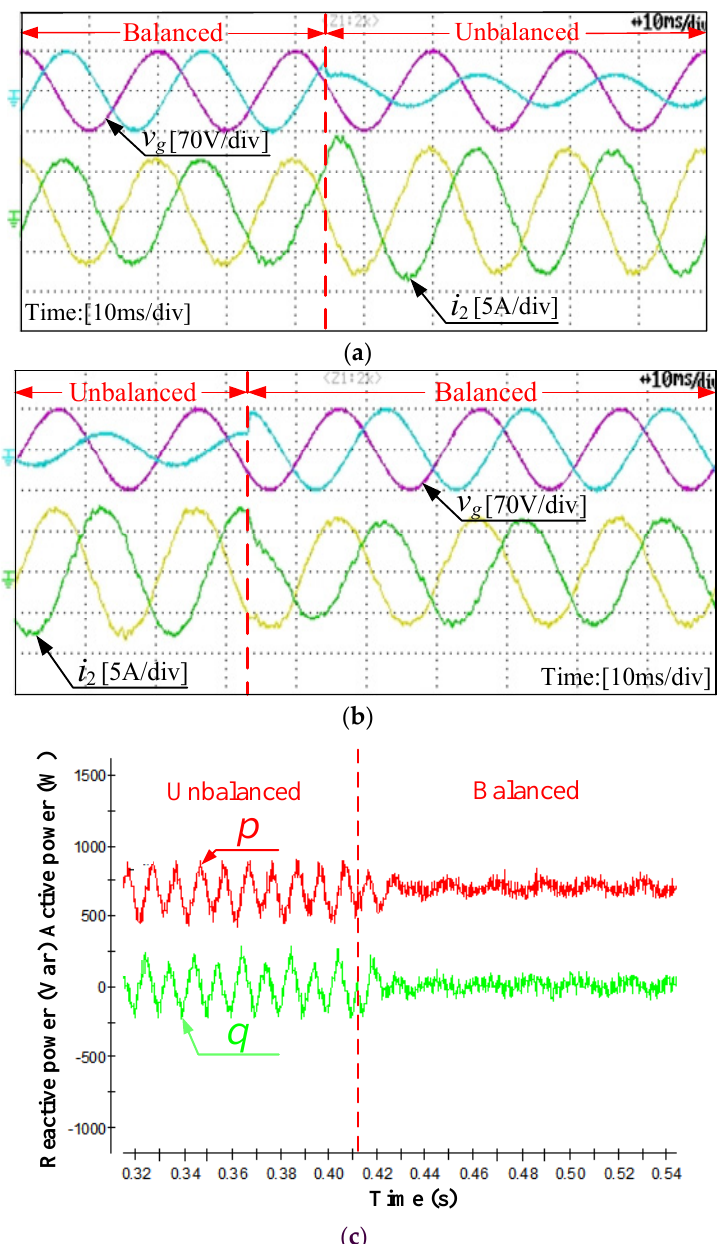
Figure 15. Experimental results of ( a ) grid-injected current when grid voltage varies from balanced to unbalanced, ( b ) grid-injected current when grid voltage varies from unbalanced to balanced, and ( c ) active and reactive power when grid voltage varies from unbalanced to balanced in case 3.